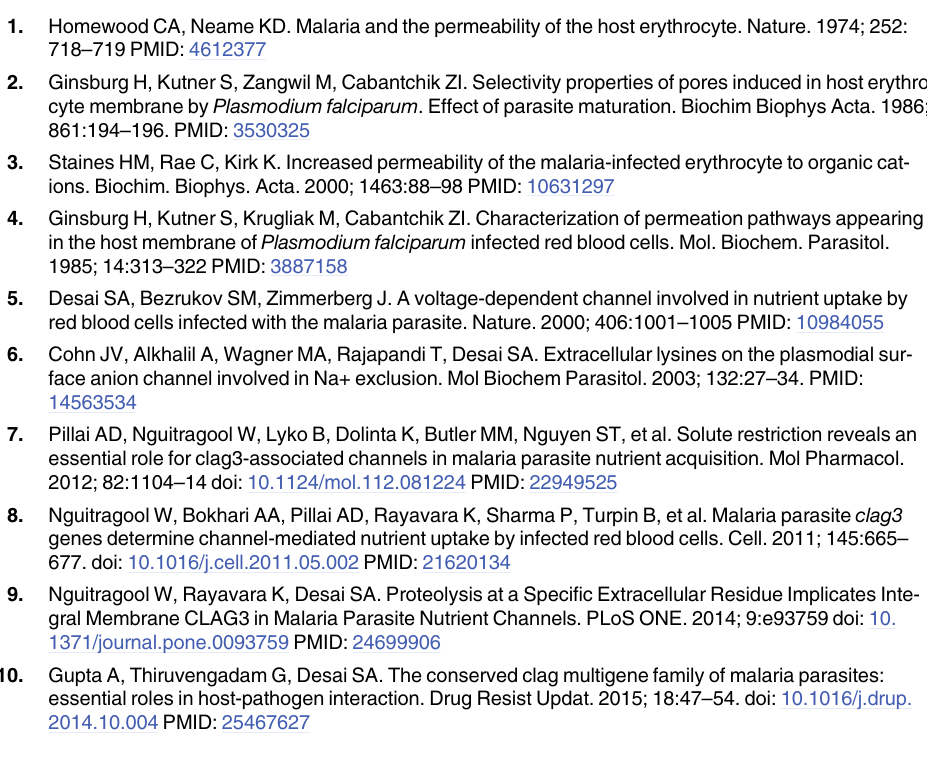
S1 Table. Summary of mass spectrometry results. Each tab represents an independent mass spectrometry experiment analyzed with PEAKS v.